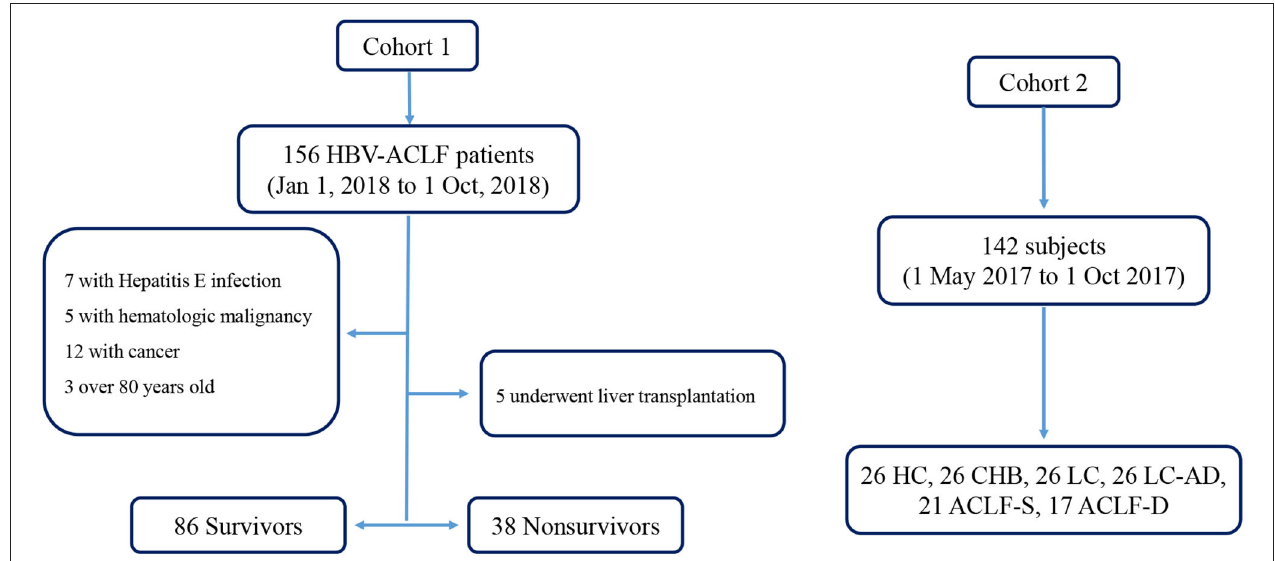
FIGURE 1 | Flow chart of enrolled cohorts. ACLF-D, acute-on-chronic liver failure-death; ACLF-S, acute-on-chronic liver failure-survival; CHB, chronic Hepatitis B; HBV-ACLF, Hepatitis B related acute-on-chronic liver failure; HC, health control; LC, liver cirrhosis; LC-AD, liver cirrhosis-acute decompensation.